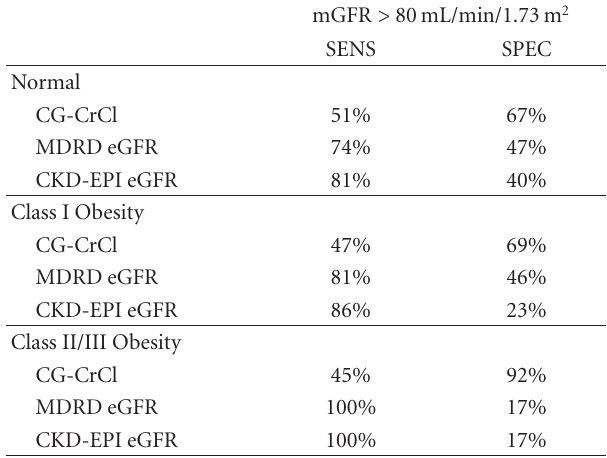
Table 4: Sensitivity and specificity of estimating